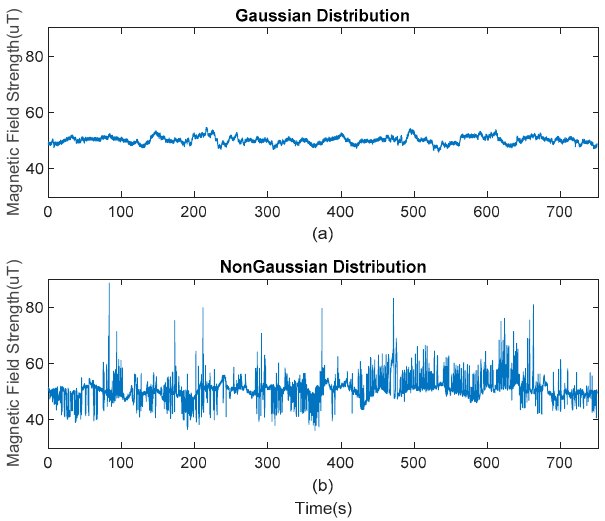
Figure 3. Magnetic field observations under different conditions: ( a ) an interference-free condition and ( b ) an interference condition.